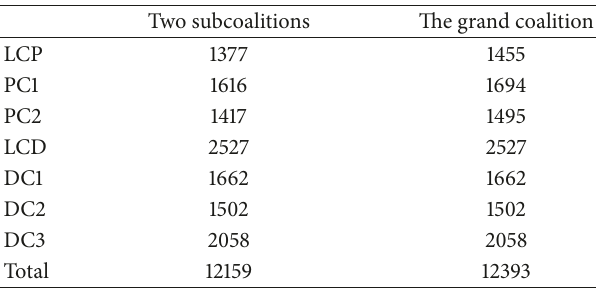
Table 13: Comparison of different network